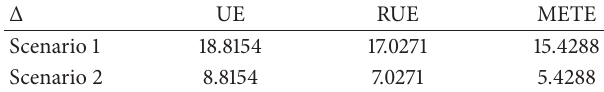
Table 3: Optimal parking